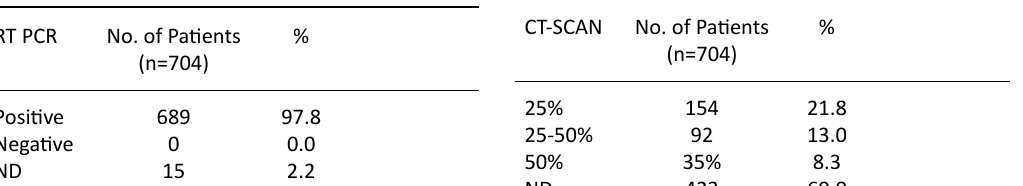
Table 2. Reverse Transcriptase Polymerase Chain Reaction (RTPCR) distribution in COVID 19 patients